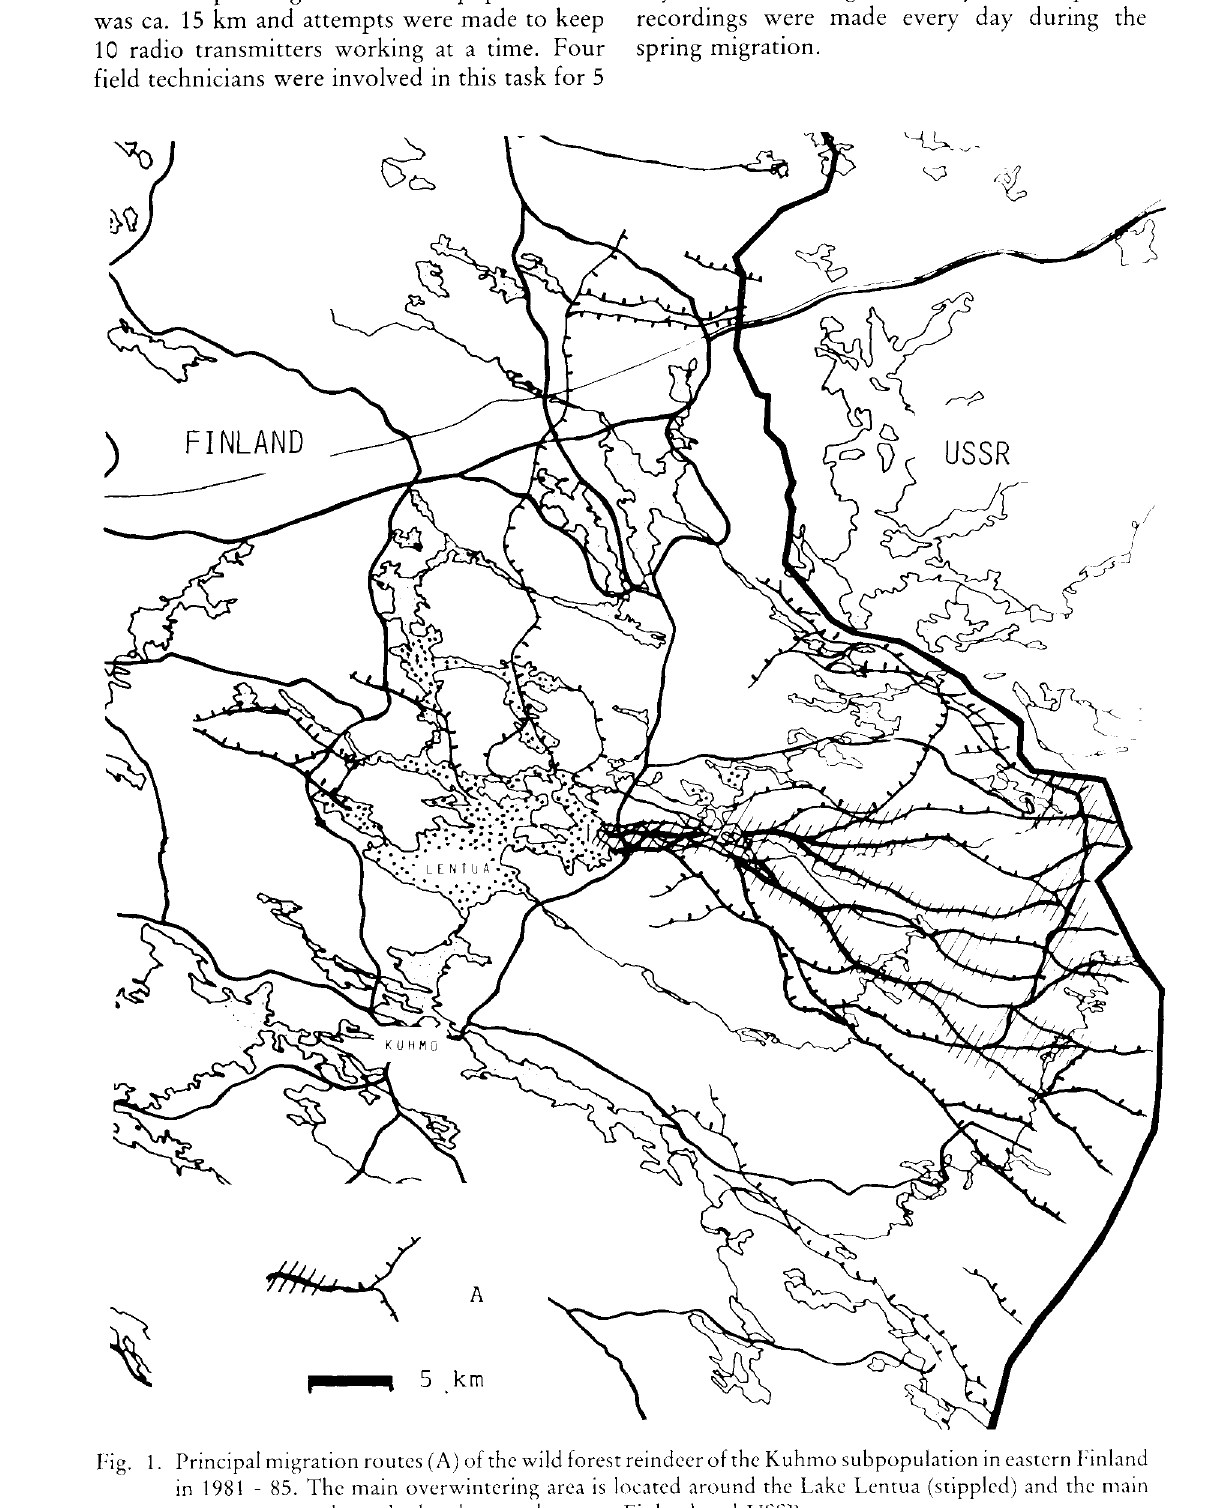
Fig. 1. Principal migration routes (A) of the wild forest reindeer of the Kuhmo subpopulation in eastern Finland in 1981 - 85. The main overwintering area is located around the Lake Lentua (stippled) and the main summer range along the border area between Finland and